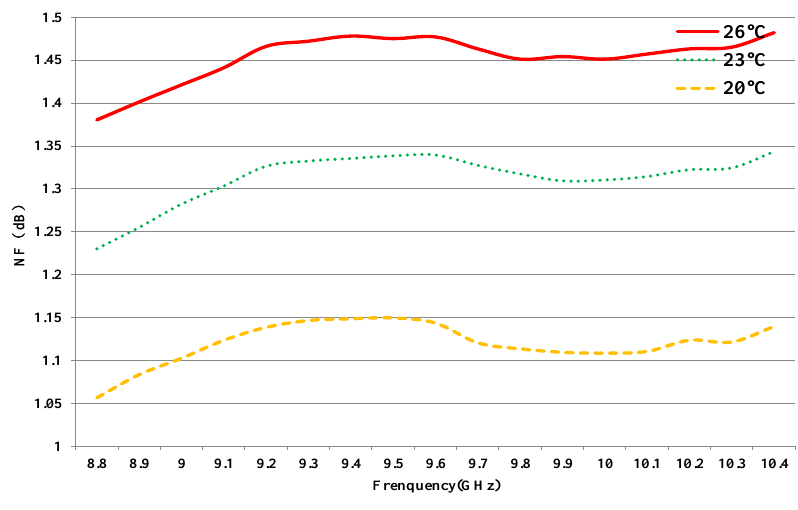
Figure 11. NF result influenced by ambient temperature.